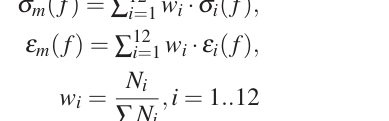
Fig.1: Contribution of the brain, skin, and CSF into the REG’s amplitude brain, cerebral spinal fluid, and blood. These modifications were applied only to the finite elements lying on the borders between the brain and